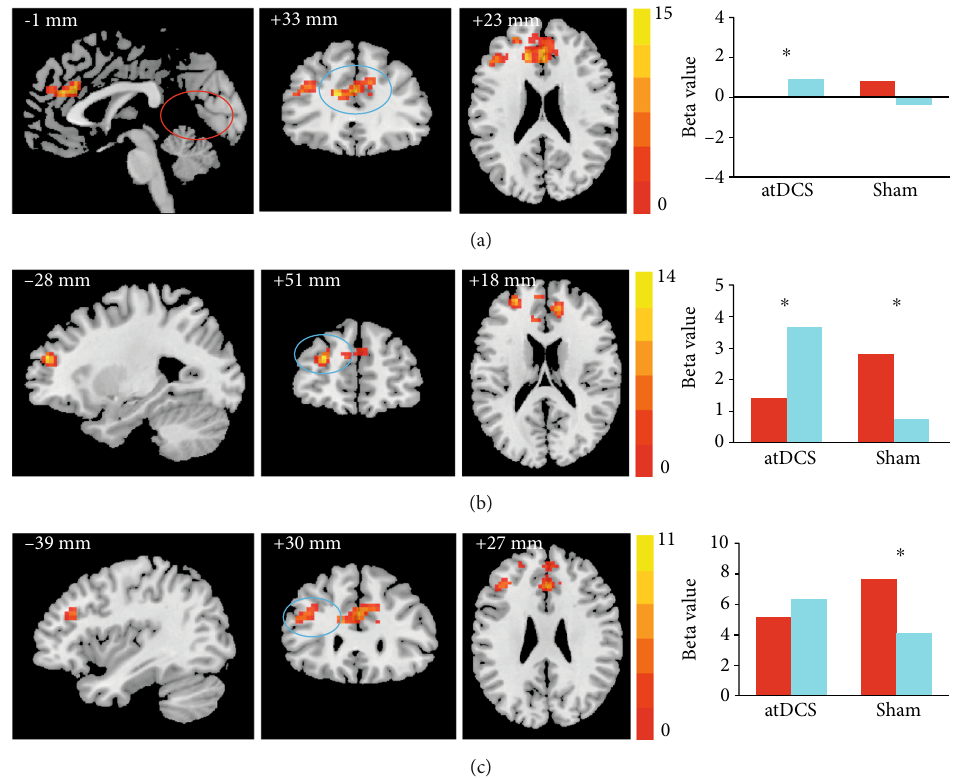
Figure 3: Visual maps for anodal transcranial direct current stimulation- (atDCS-) related activity alterations during item memory. Brain regions showed signi fi cant Group × Test time interactions in activation for (a) the bilateral anterior cingulate cortex (Brodmann area (BA) 32), (b) the left middle frontal gyrus 1 (BA 10), and (c) the left middle frontal gyrus 2 (BA 9/46, corrected for multiple comparisons with Monte-Carlo simulation, p < 0 : 05 ). Color bars are representative of F scores. Bar plots at the right show the mean beta values of brain activity in these regions before and after stimulation, for the atDCS and sham